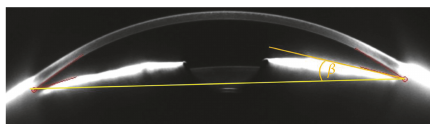
Figure 1: Illustration of iris conicity measurement. The iris surface is approximated by linear slopes (orange line). For illustration purposes, iris conicity is demonstrated. The opposite anterior chamber angles are connected by a plane (yellow line). Iris conicity is de fi ned as the angle beta between these two lines. This corresponds to Pentacam “ iris convexity ” measure. Pentacam “ iris convexity ” is de fi ned as half of the intersection angle of the linear slopes through the anterior surface of opposite iris cross-sections.